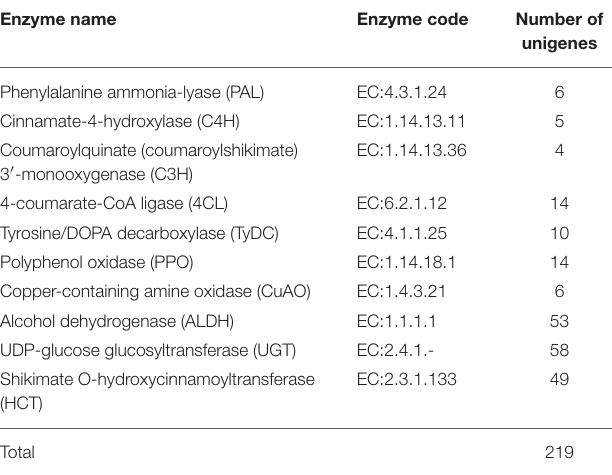
TABLE 2 | The numbers of unigene involved in acteoside biosynthesis of R. glutinosa